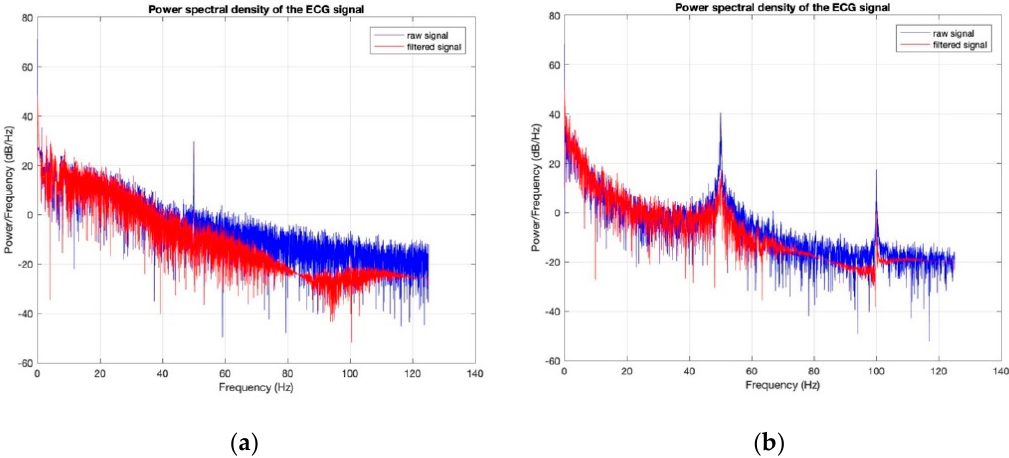
Figure 20. Power Spectral Density of ECG signal obtained by 100% cotton electrodes with 7.4 wt.% PEDOT:PSS: ( a ) before washing; ( b ) after 50 washing cycles.